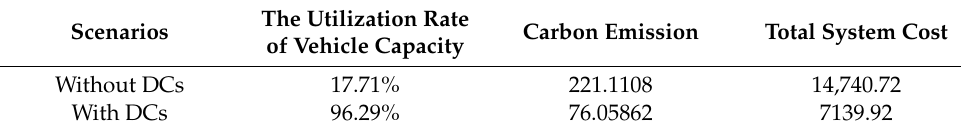
Table 8. Comparative analyses between without and with DCs.